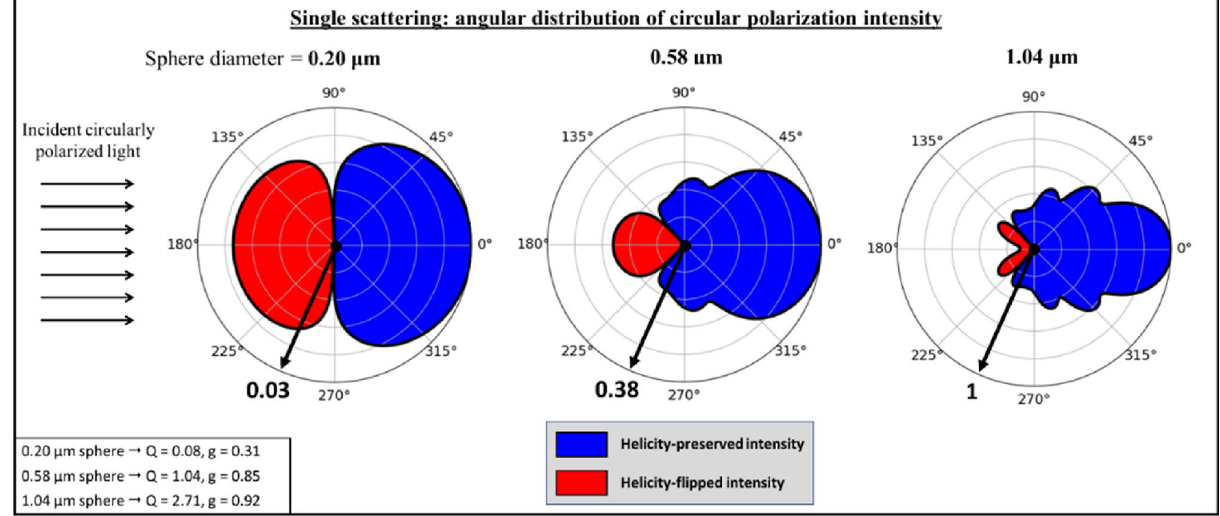
Figure 2. The sign and intensity of singly-scattered circularly polarized light depends on scattering angle and scatterer size, visualized on polar plots (log scale) for three sphere sizes, 0.20 μm, 0.58 μm, and 1.04 μm. The magnitude of each polar plot is scaled by the scattering efficiency of 1.04 μm spheres (Q = 2.71), as indicated by the thick black arrows at 7 o’clock positions. The Mie parameters for the calculation were: light wavelength in vacuum (cid:31) = 635 nm, host medium refractive index n m = 1.33 (water), and scatterer refractive index n s = 1.59 (polystyrene). The calculated scattering efficiencies, Q, and scattering anisotropy factors, g, for each sphere diameter are shown in the bottom left. Helicity flipping occurs only in the backward direction, increasing in angular extent and in relative intensity as sphere size